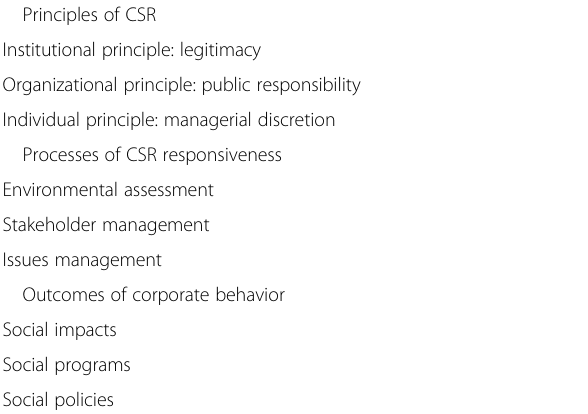
Table 1 The corporate social performance